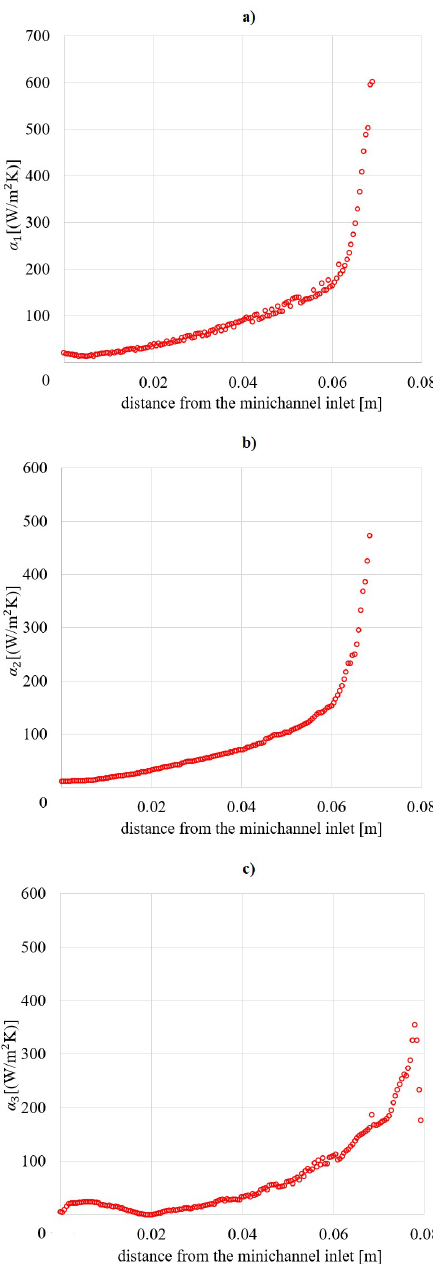
Fig. 9. Heat transfer coefficient versus the distance from the minichannel inlet: a) α 1 - PV